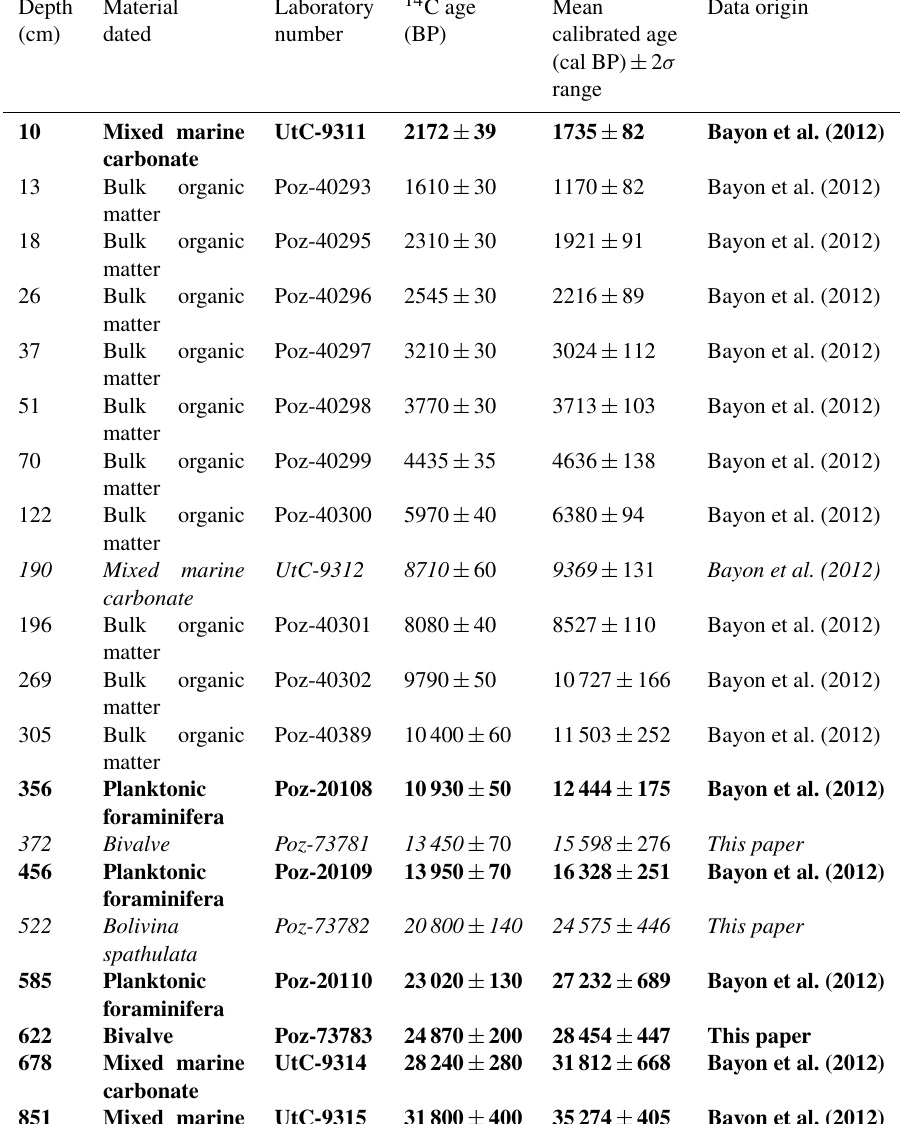
Table 1. 14 C dates obtained on the KZAI-01 core: 7 dates were previously obtained on marine carbonate material and 10 on bulk organic matter (Bayon et al., 2012), and 3 new dates have been added in this study. Two dates have been rejected (190 and 372cm) and displayed in italic, and dates acquired on bulk organic matter have not been considered for the establishment of the age model in this study (dates retained for the age model are given in bold in the